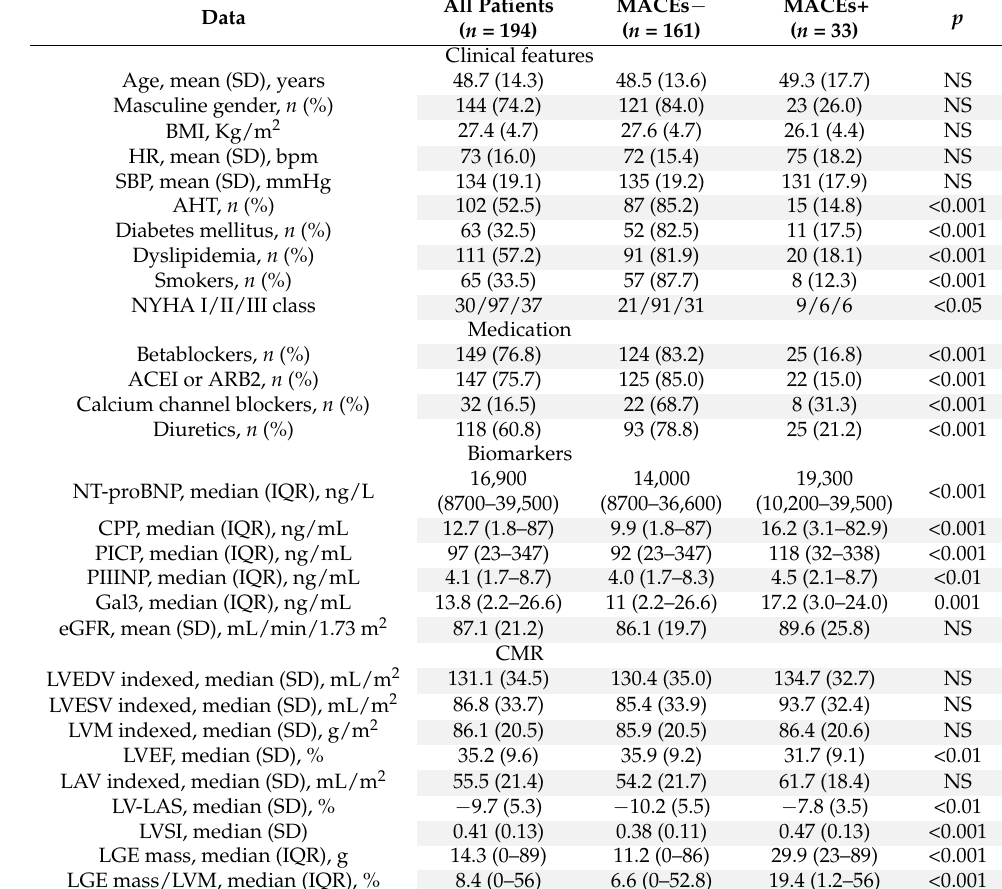
Table 3. Comparison between patients with NIDCM who reached MACEs and the others.